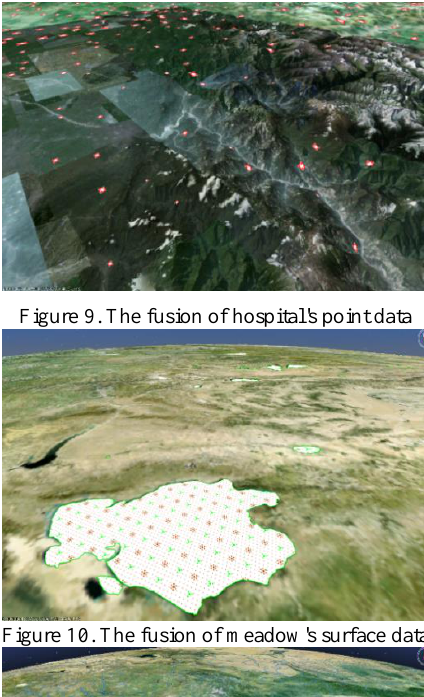
Figure 10. The fusion of meadow's surface data